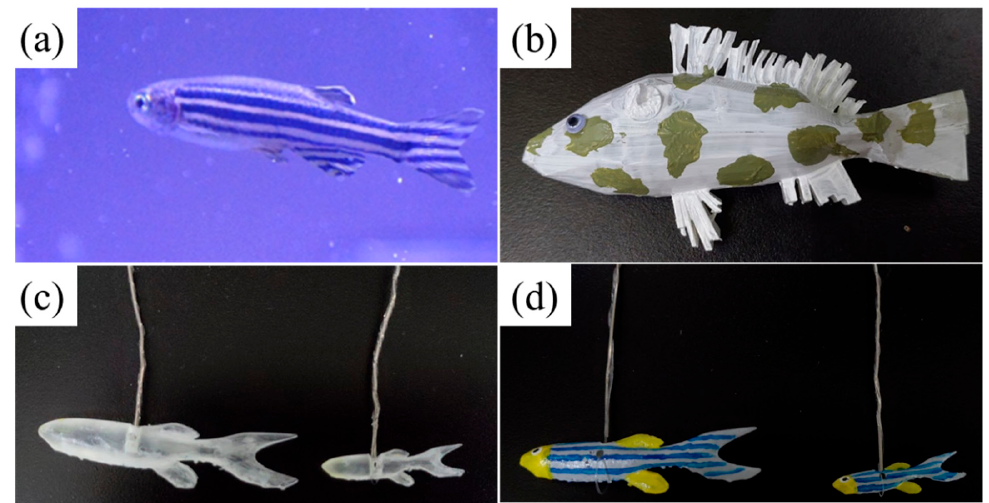
Figure 3. The appearances of ( a ) living zebrafish, ( b ) an Indian leaf fish replica, ( c ) transparent zebrafish replicas of different sizes, and ( d ) colored zebrafish replicas of different sizes.